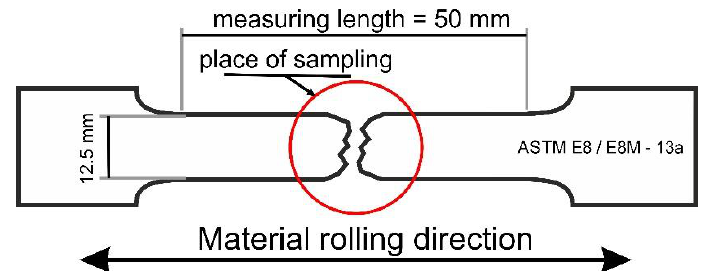
Figure 1. Tensile sample with the marked area of sampling for microstructural analysis.